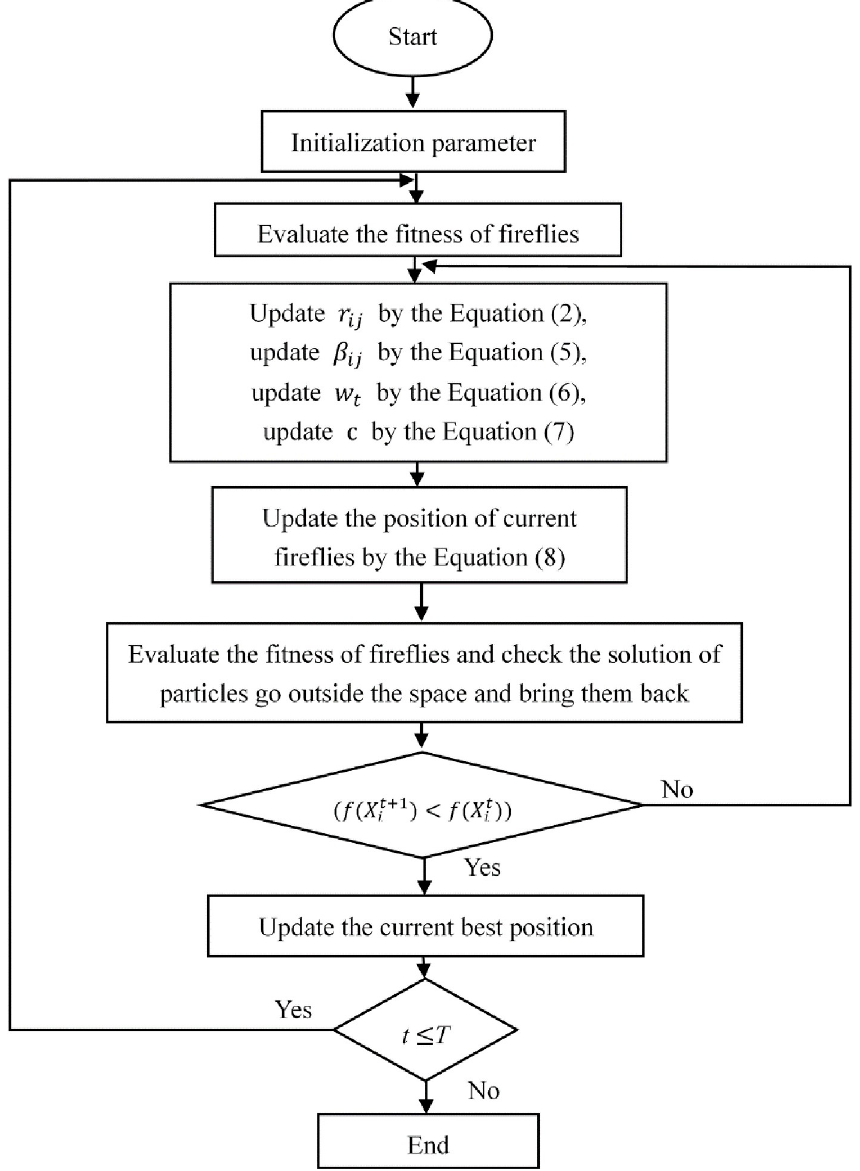
Fig 8. The flow chart of the